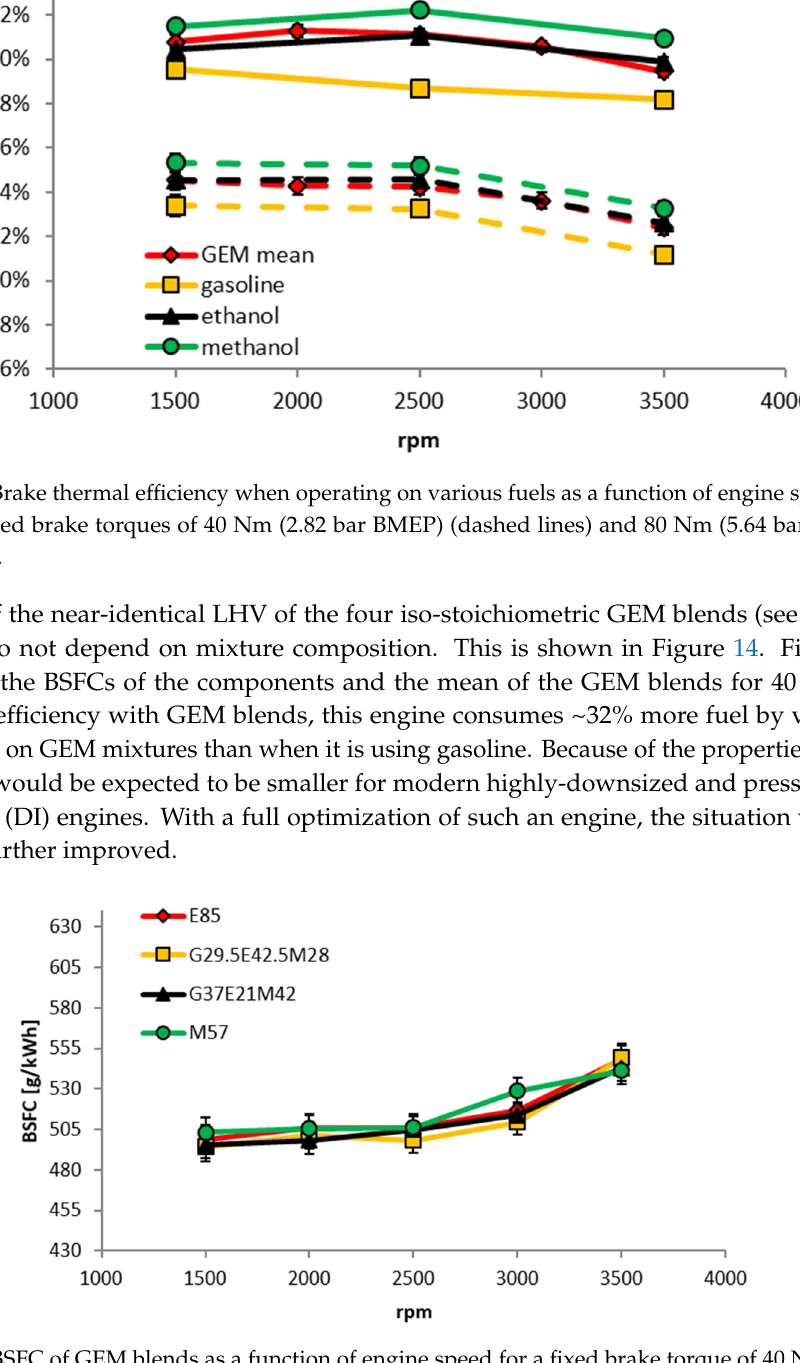
Figure 14. BSFC of GEM blends as a function of engine speed for a fixed brake torque of 40 Nm (2.82 bar BMEP).